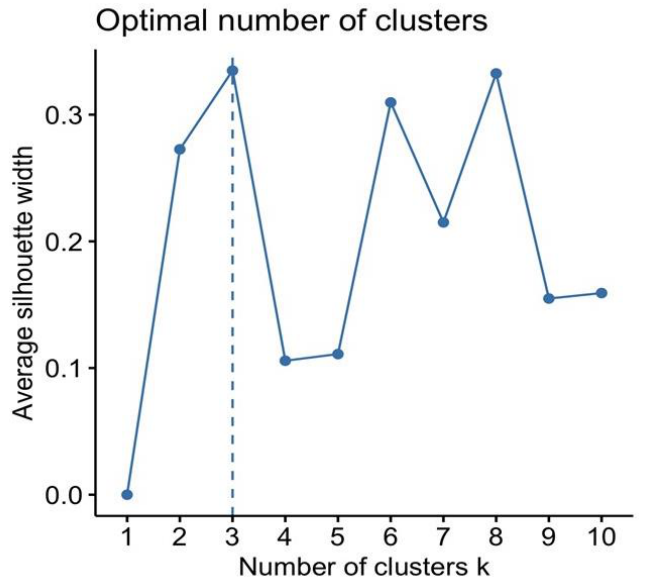
Figure 2. Optimal number of clusters according to the Silhouette method; the optimal number of clusters was three based on the highest average Silhouette value.